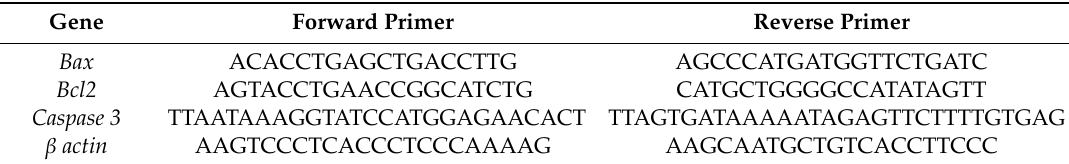
Table 5. Primers used for real-time